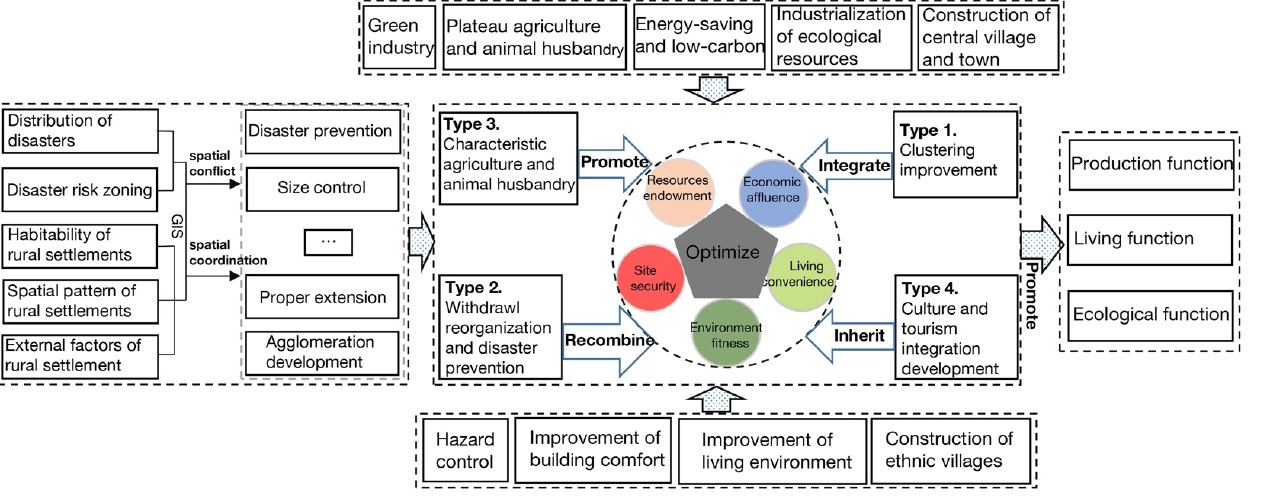
Figure 6. Optimization Model of Rural Settlement Livability in the Upper Reaches of the Min- jiang